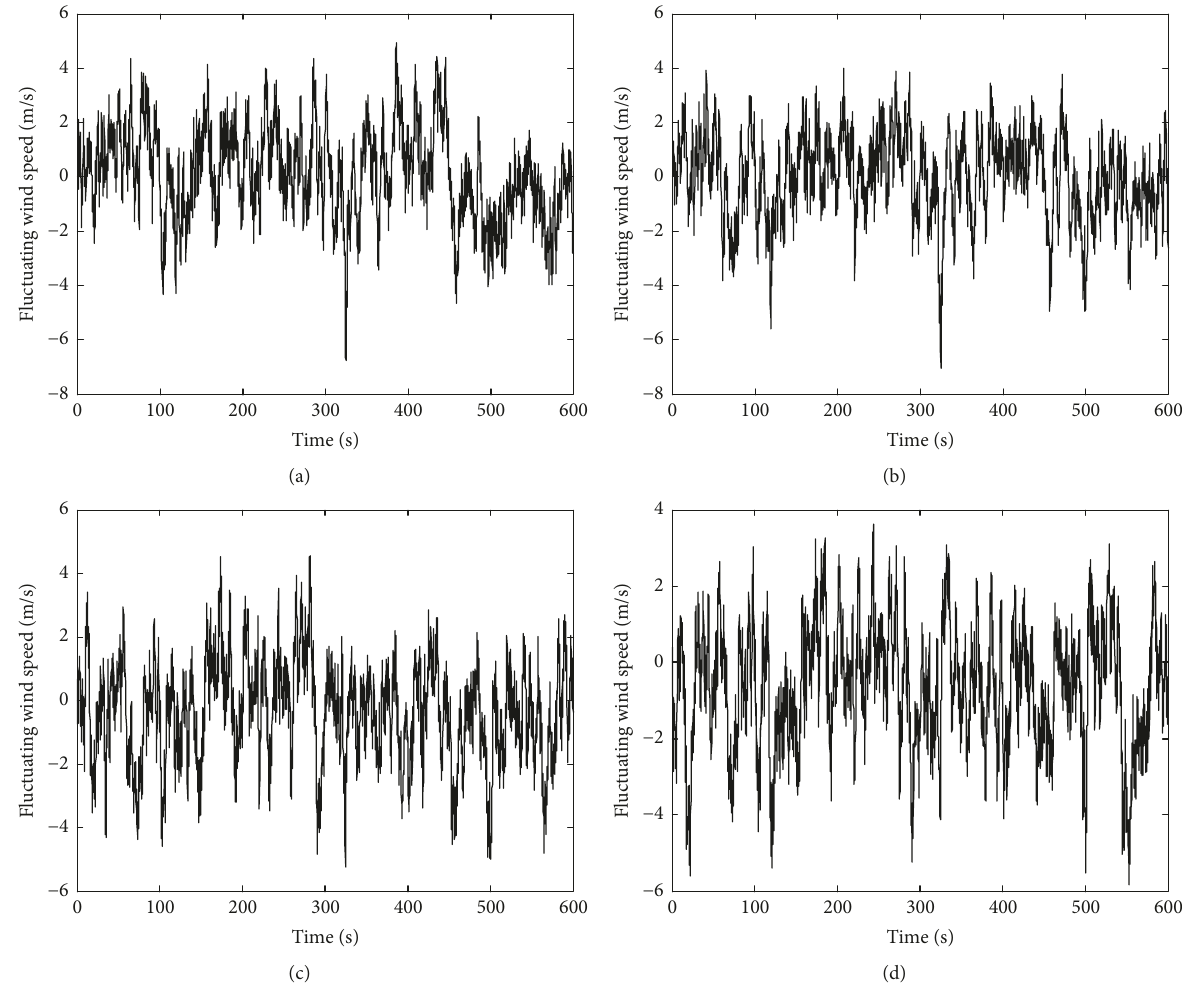
Figure 1: Simulated fluctuating wind speed. (a) On the 5th floor; (b) on the 10th floor; (c) on the 15th floor; (d) on the 20th floor.